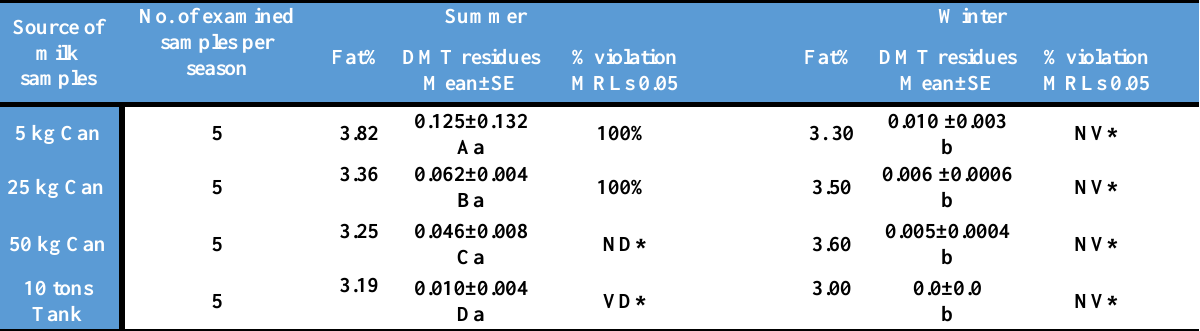
Table, 4: Seasonal variation of the mean levels of Deltamethrin residues in raw cow's milk samples collected from equipment of different from the milk reception and collection center in Abu-Ghraib village. Source